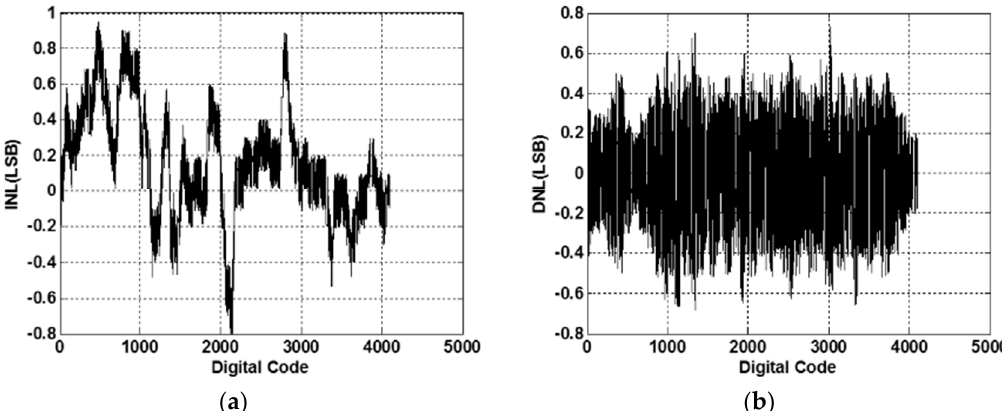
Figure 15. Performance of ( a ) INL and ( b ) DNL of the 12-bit hybrid SAR ADC. Table 1. Performance comparison with other interpolation methods.